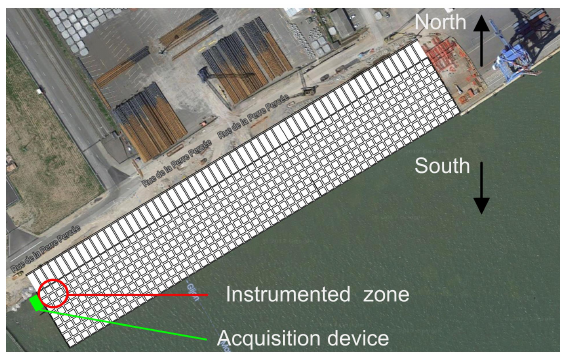
Figure 3. Zone of interest.